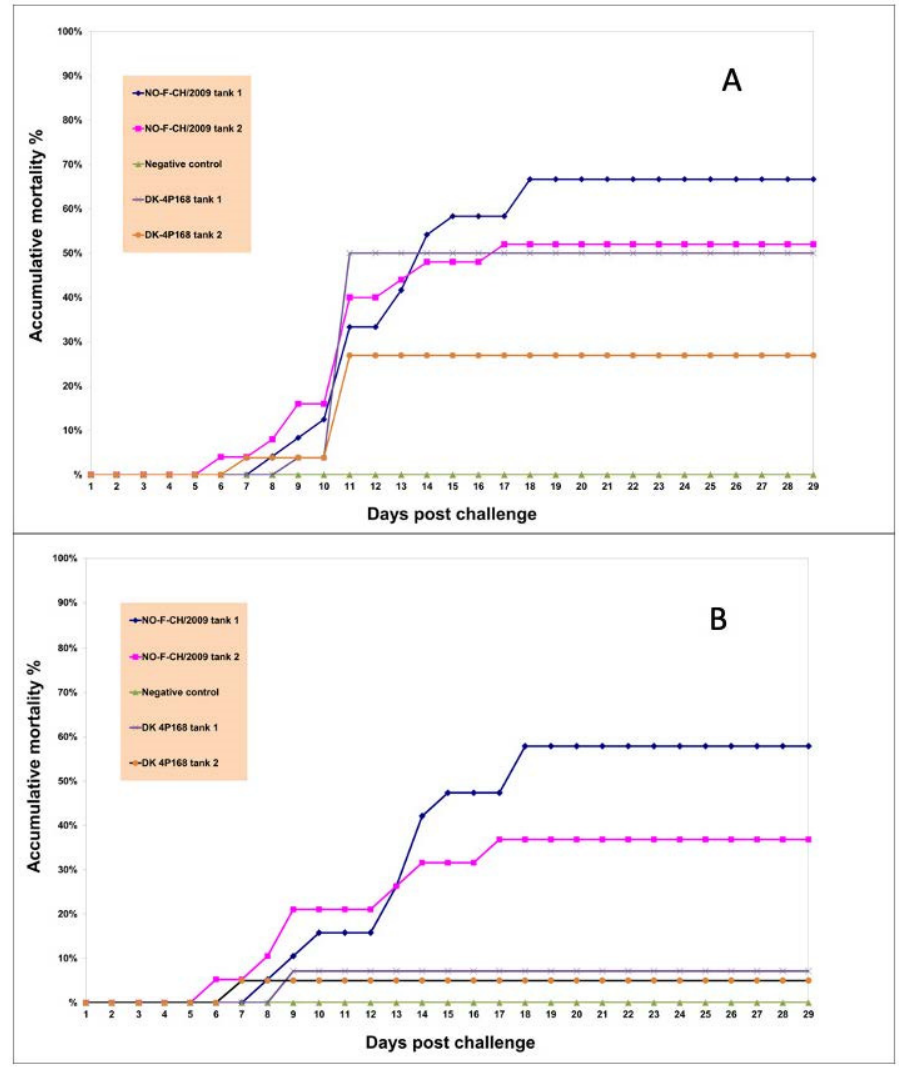
Figure 2. ( A , B ). Mortality in the three experimental groups of Atlantic herring, Clupea harengus , challenged with the VHSV genotype Ib isolate NO-F-CH/2009, the VHSV genotype III isolate 4p168, and the unchallenged control. In ( A ), all raw data are used, including mortality induced by the accident at day 11. In ( B ), the fish lost by the accident are subtracted, displaying only the mortality that could be related to the challenge.